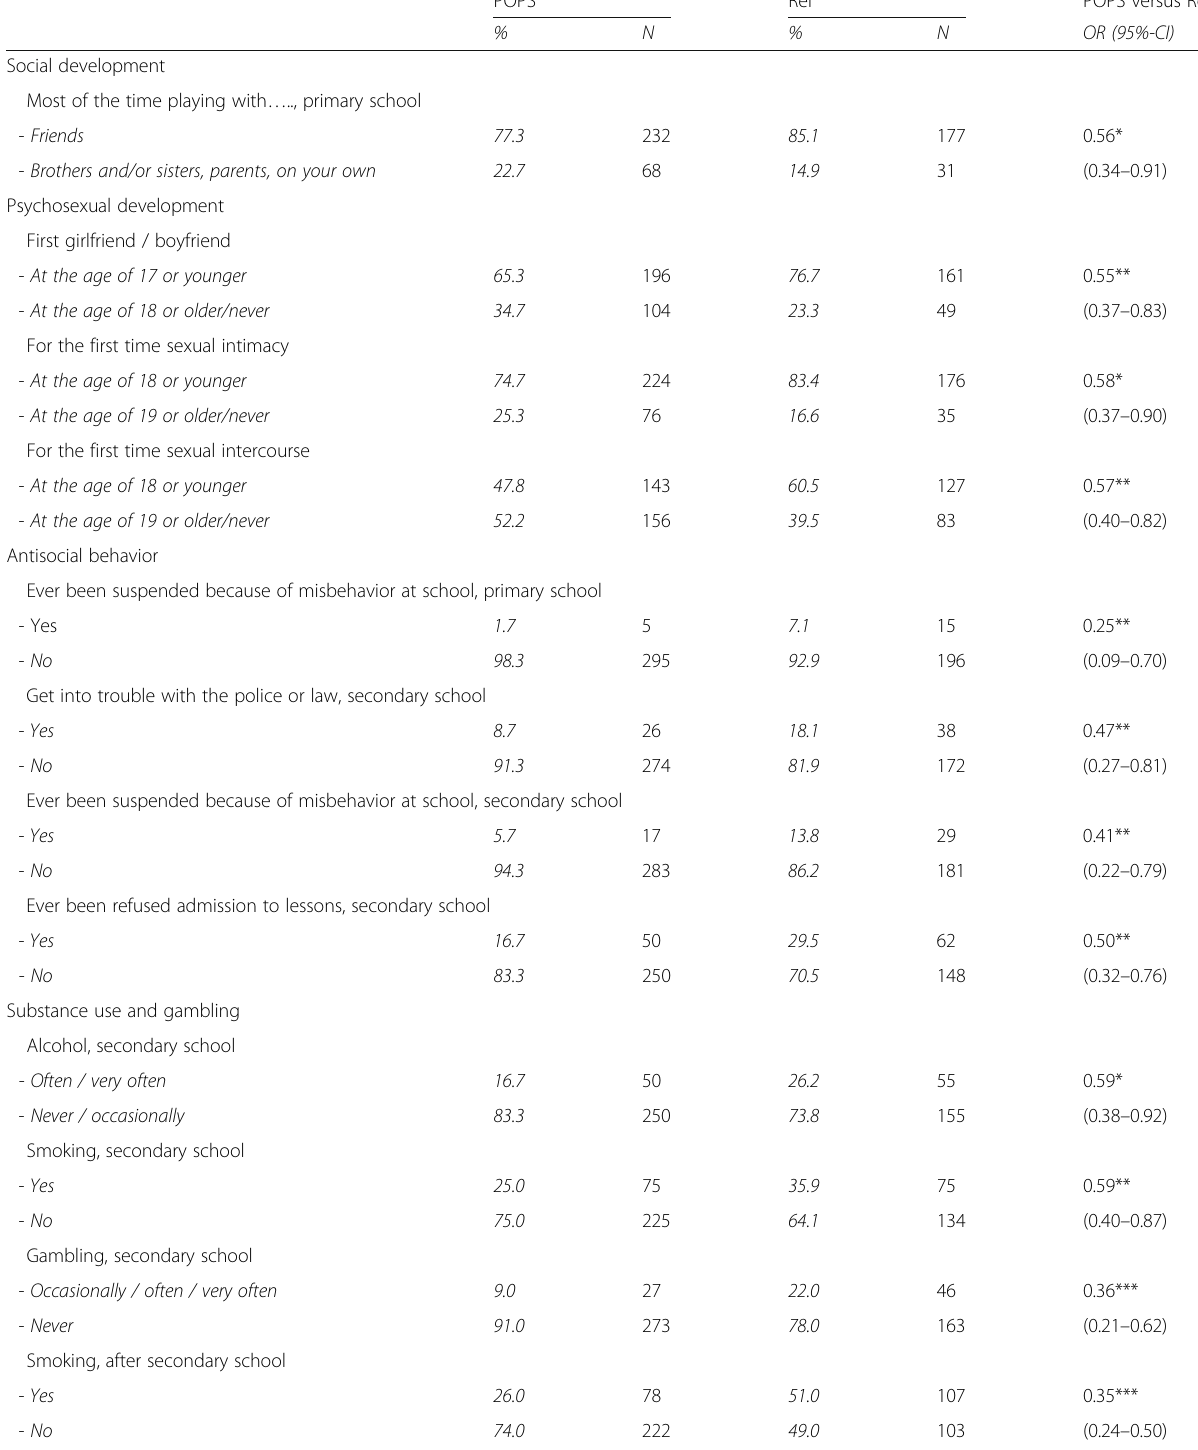
Table 4 Psychosocial development trajectory of POPS-group vs Ref-group: significant differences on item-level (milestones) Course of life